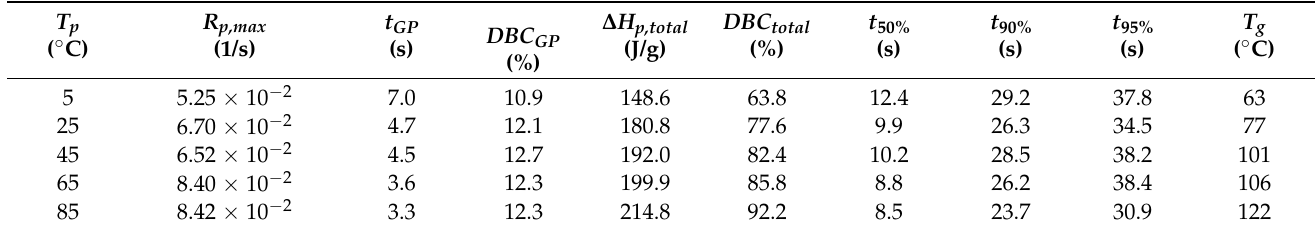
Table 1. Photo reactivity of UrDMA containing 1 wt.% TPOL under N 2 atmosphere at different temperatures obtained from photo-DSC data.